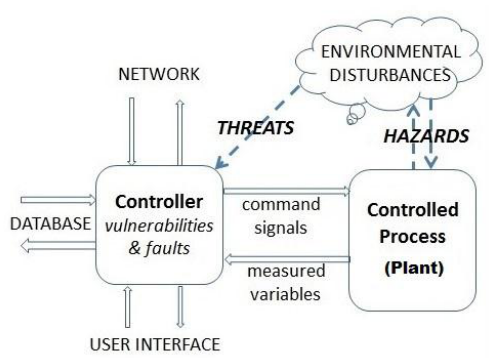
Figure 5. Illustration of basic terms and an attack surface.